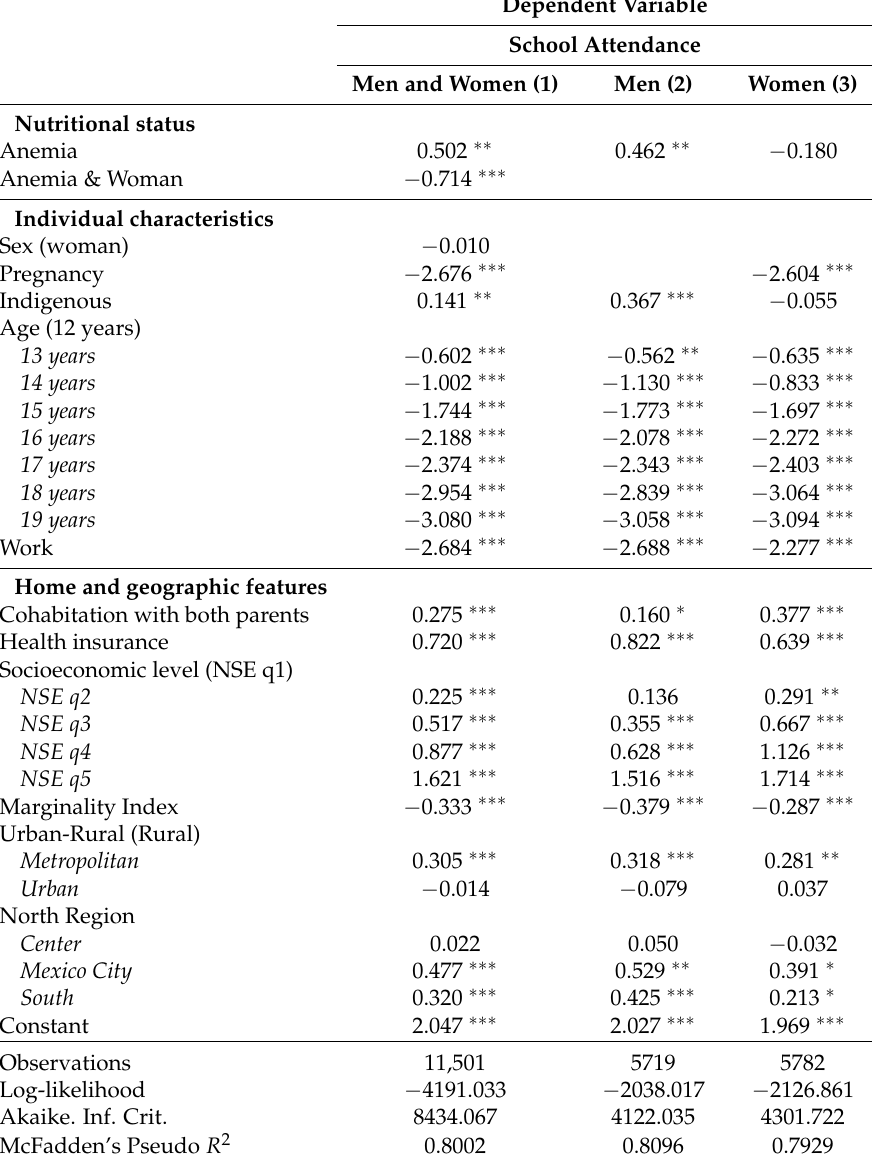
Table A4. Estimation of the marginal coefficient of logistic regression school